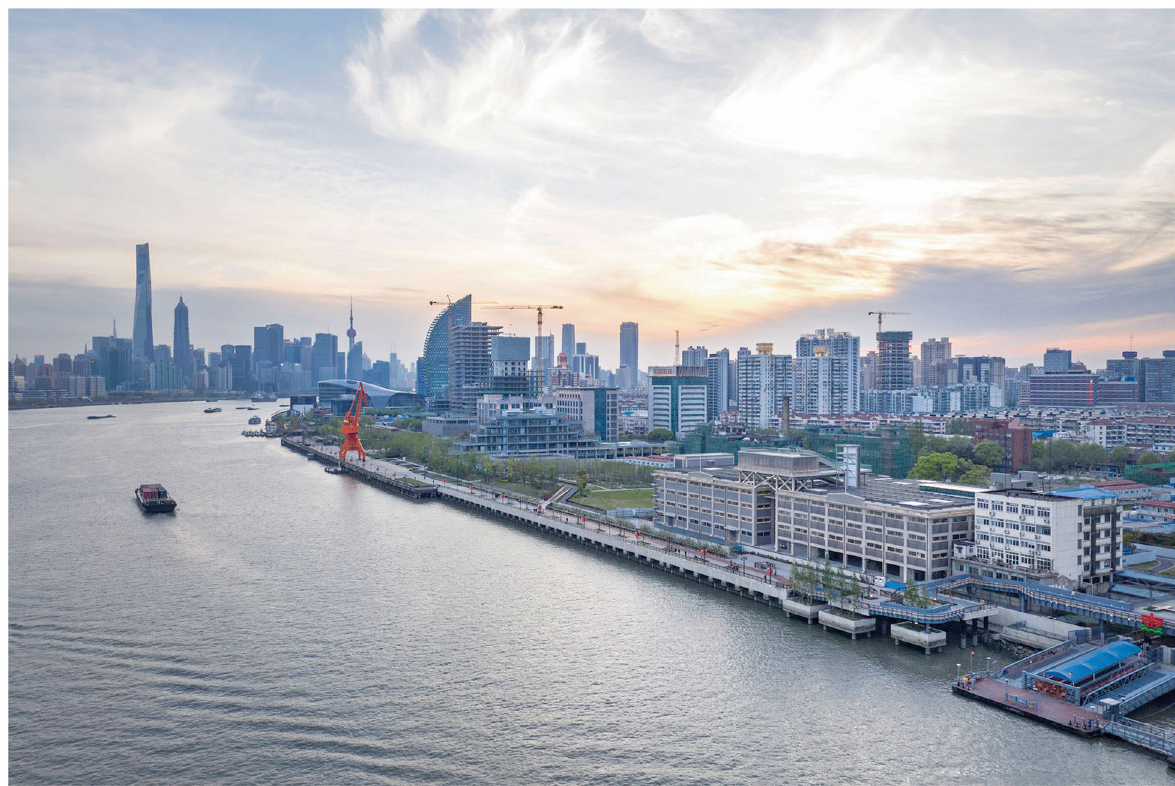
Fig. 3 An overview of the Yangpu waterfront and Yong ’ an Warehouse (Source: Fangfang